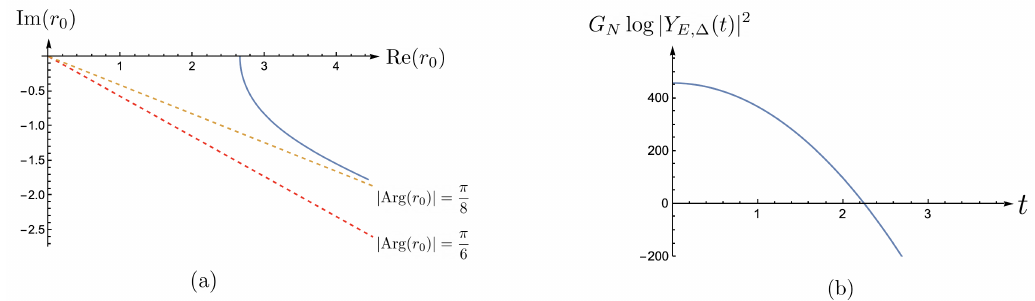
Figure 15 . In the plots we have E = 10 2 , ∆ 2 = 10 2 , and the AdS radius ‘ is set to one. (a) We G N G N show the trajectory of r 0 as we increase time. It is always in the allowable region. The boundary of the allowable region is shown by the red dashed line. (b) We show the answer of the spectral form factor given by the semiclassical black hole. It decays to exponentially small at order one